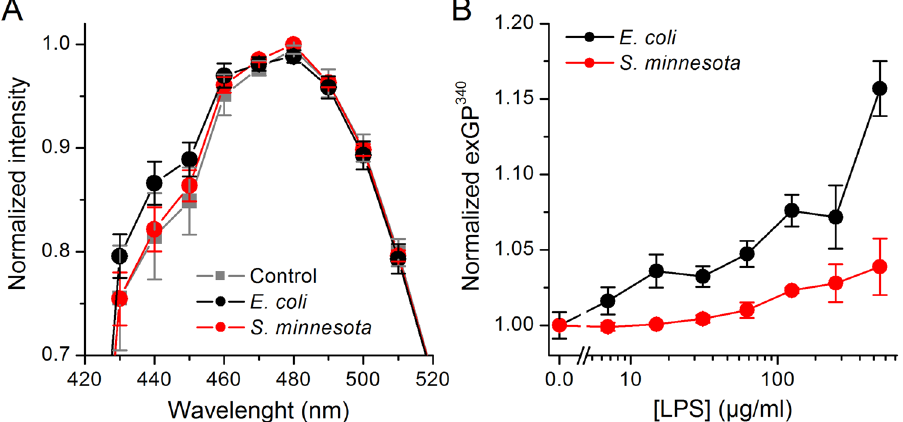
Figure 5. Differential effects of E . coli and S . minnesota LPS on Laurdan’s emission spectrum. ( A ) Laurdan’s emission spectra recorded at 37 °C in DPhPC GUVs in control and after treatment with 100 µ g/ml of E . coli or S . minnesota LPS. ( B ) exGP 340 determined at 37 °C in HEK293T cell exposed to E . coli or S . minnesota LPS applied at different concentrations. The values were normalized to those obtained in control condition. Data is shown as mean ± s.e.m. from at least three samples performed in at least